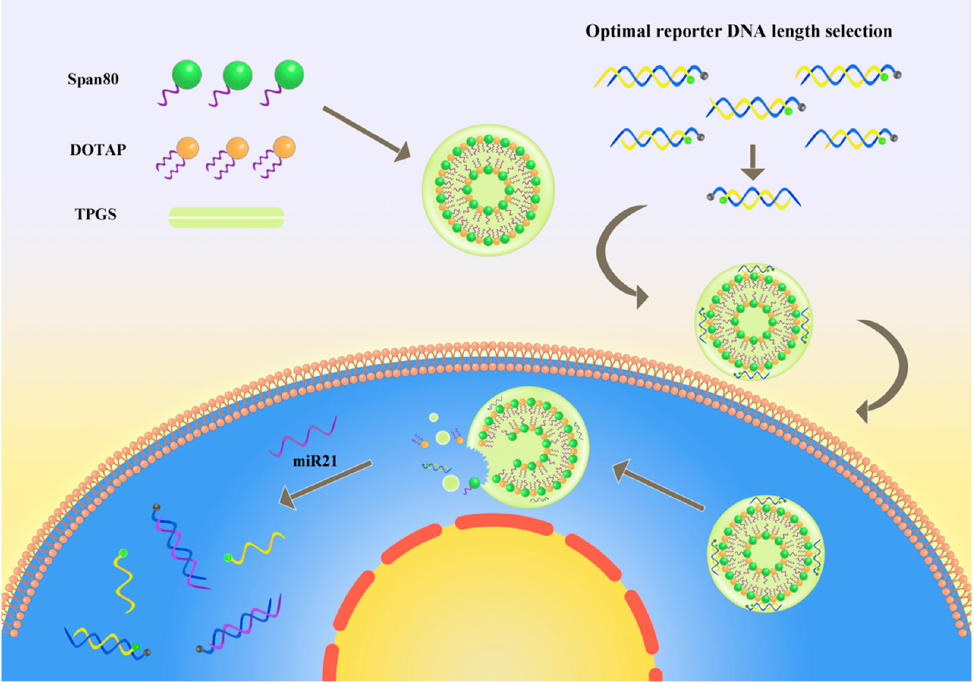
Scheme 1. Schematic illustration showing the optimization and assembly process of niosome/dsDNA platform and miR21 biosensing in cancer cells.